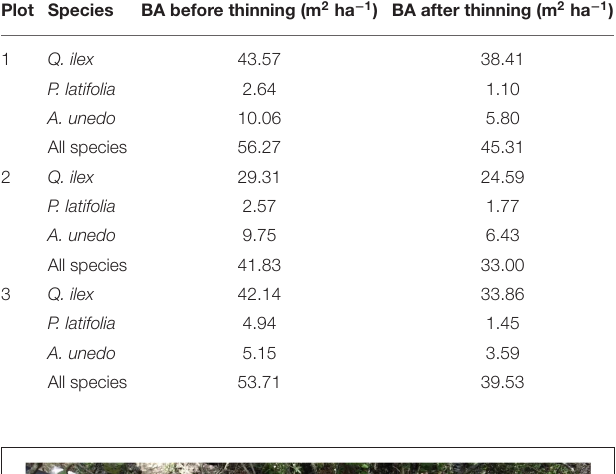
TABLE 1 | Basal area (BA) of the dominant species in each thinned plot before and after thinning. Plot Species